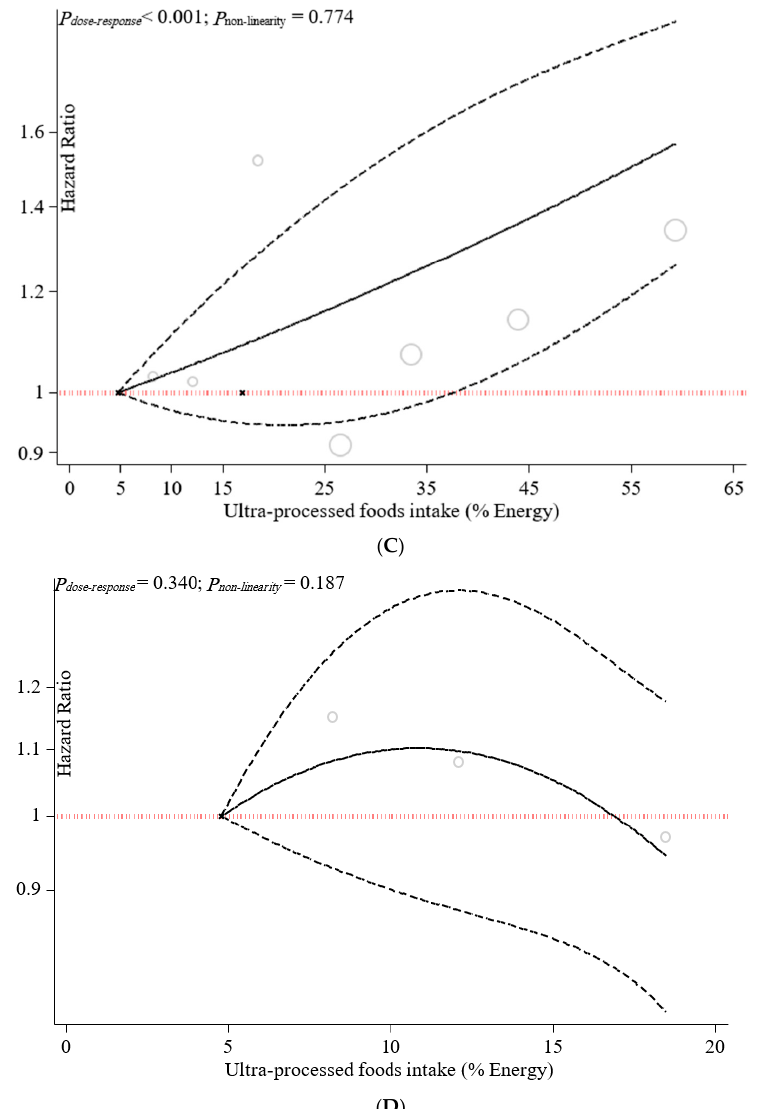
Figure 4. Dose–response association between ultra-processed food consumption and risk of mortality: ( A ) all-cause, ( B ) CVD-cause, ( C ) heart-cause, and ( D ) cancer-cause. It has been revised.